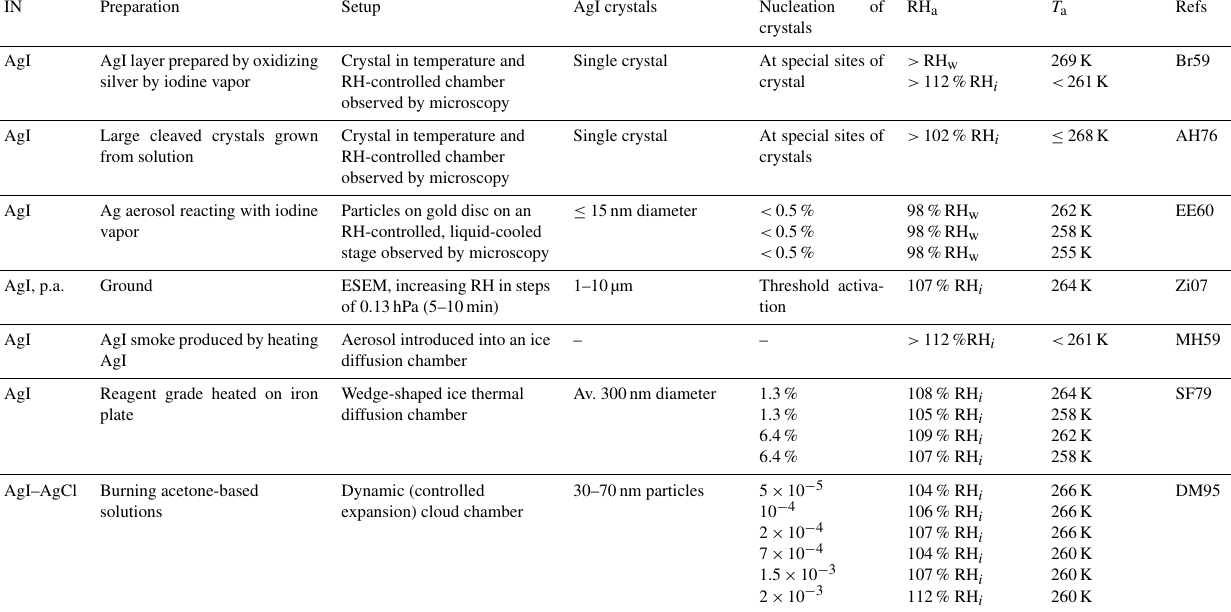
Table 4. Deposition nucleation studies. IN: ice nuclei; RH a : activation relative humidity; RH i : relative humidity with respect to ice; RH w : relative humidity with respect to water; T a : activation temperature. References: Br59 – Bryant et al. (1959); AH76 – Anderson and Hal- lett (1967); EE60 – Edwards and Evans (1960); Zi07 – Zimmermann et al. (2007); MH59 – Mason and van den Heuvel (1959); SF79 – Schaller and Fukuta (1979); DM95 – DeMott (1995). ESEM – environmental scanning electron